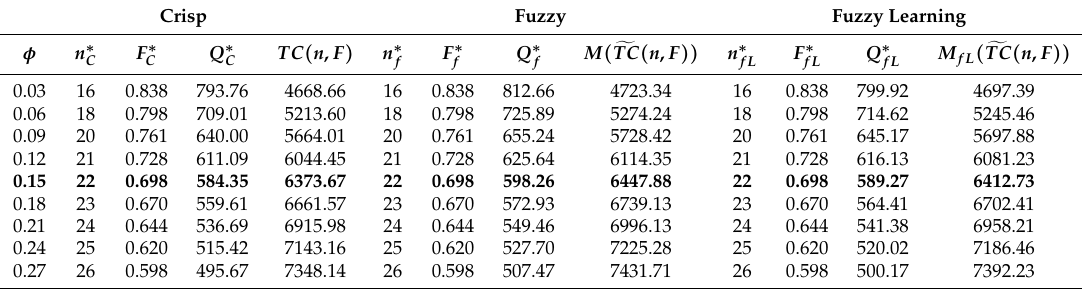
Table 4. Effect of deterioration rate ( φ ) on the crisp, fuzzy, and fuzzy-learning models.